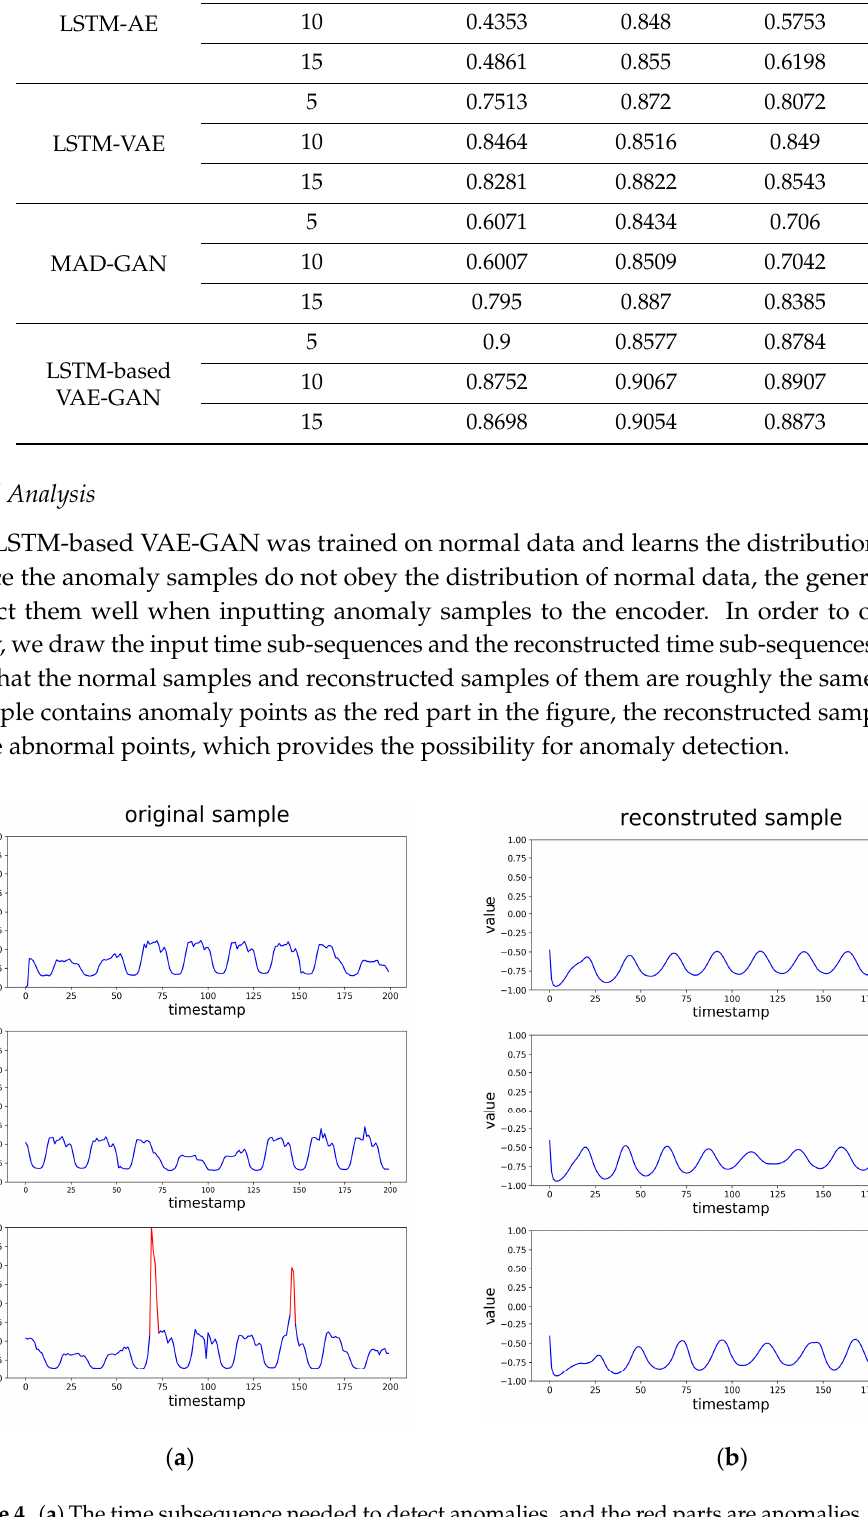
Figure 4. ( a ) The time subsequence needed to detect anomalies, and the red parts are anomalies. ( b ) The reconstructed time subsequence corresponding to the time subsequence in part